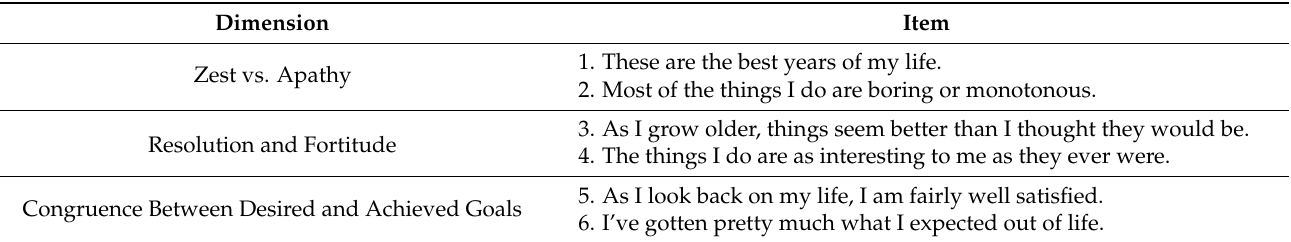
Table 1. Items and dimensions of the